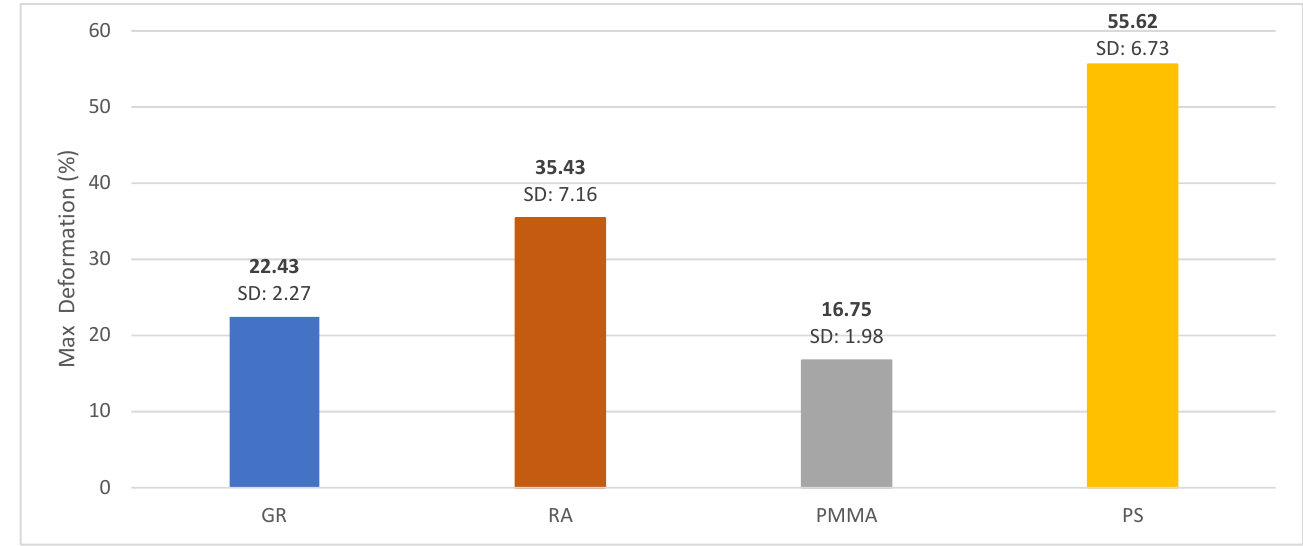
Figure 5. Mean deformation graph for GRA, RA, PMMA and PS materials.